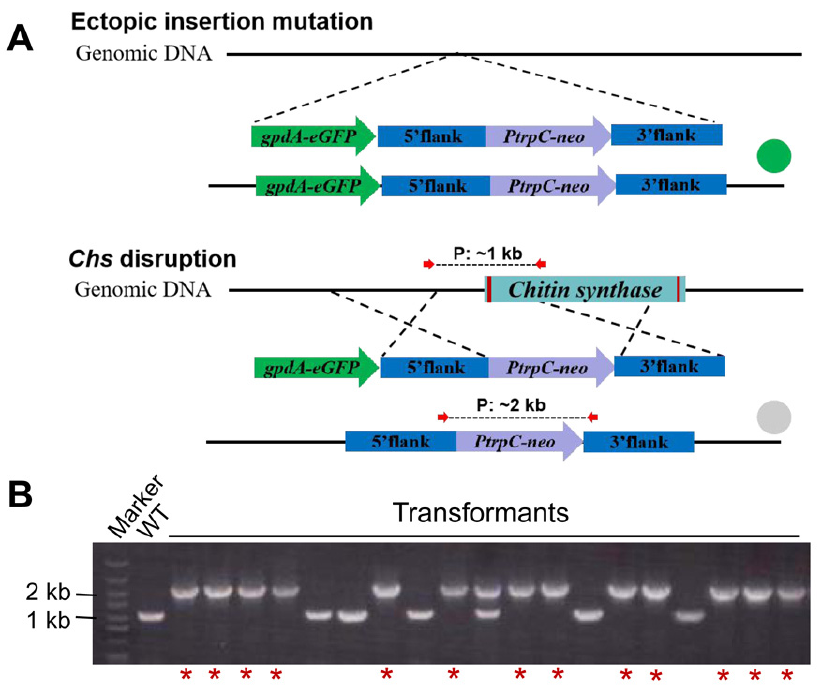
Figure 5. Evaluation of the visualized gene deletion system using Chs as a test gene. ( A ) Schematic diagram of the Chs knockout cassette integrating into the genome of F. venenatum TB01 via ectopic insertion (fluorescence) or homologous recombination (no fluorescence). ( B ) Diagnostic PCR was performed to confirm Chs deletion. The primers located in the 5 ′ flank and 3 ′ flank of the Chs knockout region are shown by red arrows, and the predicted sizes of PCR products in the wild type (~1 kb) and Δ Chs mutant (~2 kb) are shown by dashed lines. The ectopic insertion mutant contained both bands (~1 kb and ~2 kb). The confirmed Δ Chs mutants are indicated with red asterisks. Red rectangles in genomic DNA indicate the intron regions of the target gene.